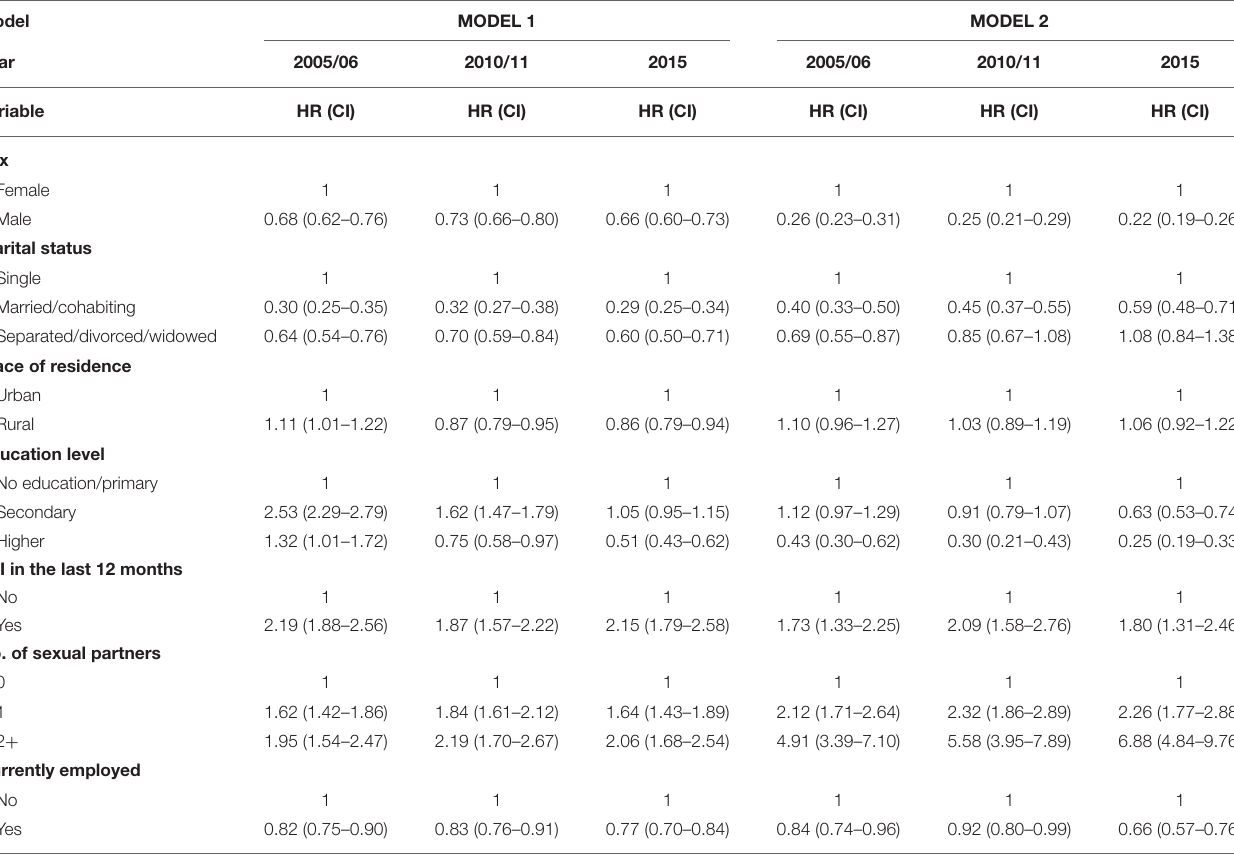
TABLE 3 | Estimated effects of covariates at baseline on the risk of HIV infection based on different survival models, Zimbabwe Demographic Health Survey (ZDHS) 2005/06, 2010/11, and